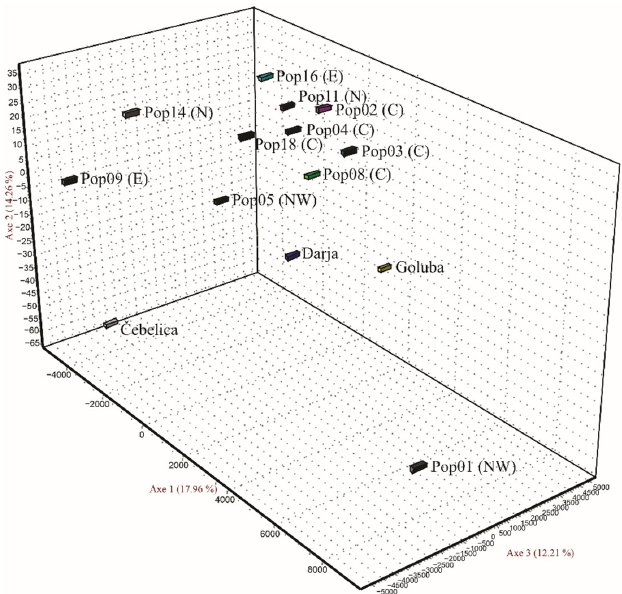
Figure 1. Multivariate analysis (Factorial Correspondence Analysis ‐ FCA) of simple sequence repeat data for 11 local landraces and three reference varieties of common buckwheat, collected